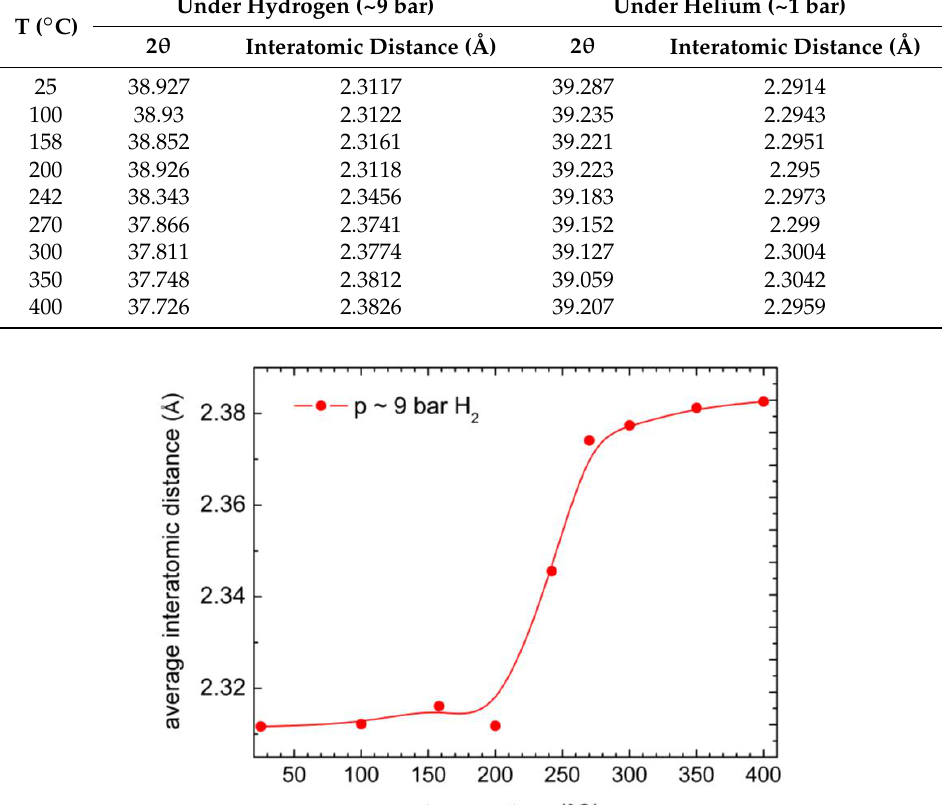
Table 2. The 2 θ value and interatomic distances at various temperatures, measured under either H 2 or He atmosphere.